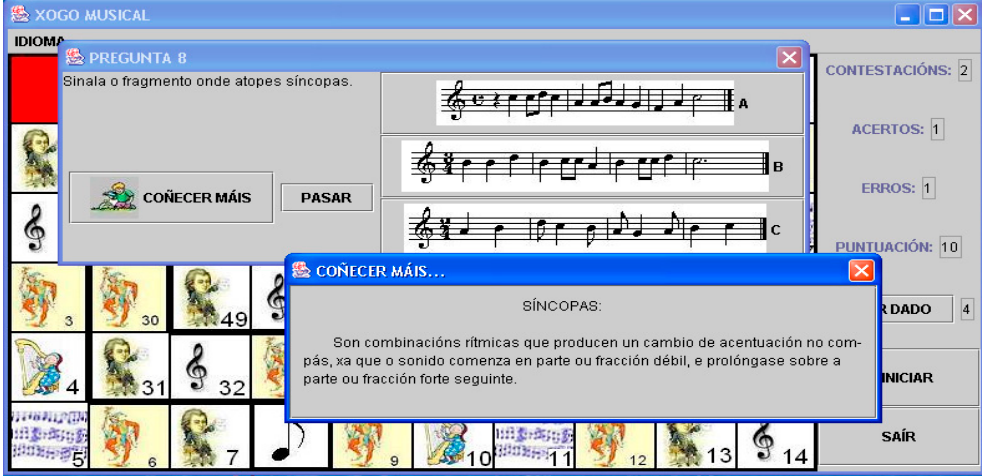
Figure 2. Example of the question of musical language and option “CONOCER MÁS” (know more).